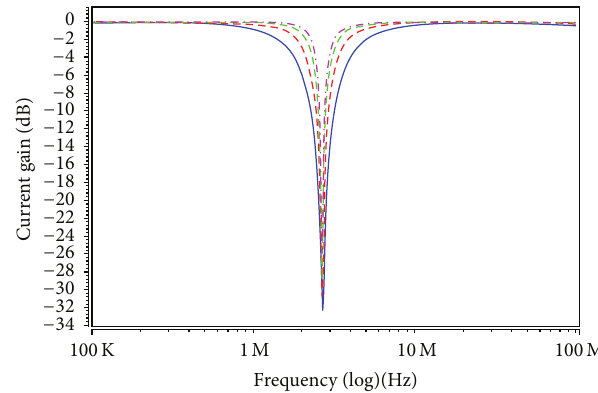
Figure 9: Electronic tunable of quality factor current-mode filter ( 𝑉 𝐶3 = 0.9 V: blue; 𝑉 𝐶3 = 1 V: red; 𝑉 𝐶3 = 1.2 V: green; 𝑉 𝐶3 = 1.65 V: pink; and 𝑉 𝐶1 = 𝑉 𝐶2 = 0.9 V).